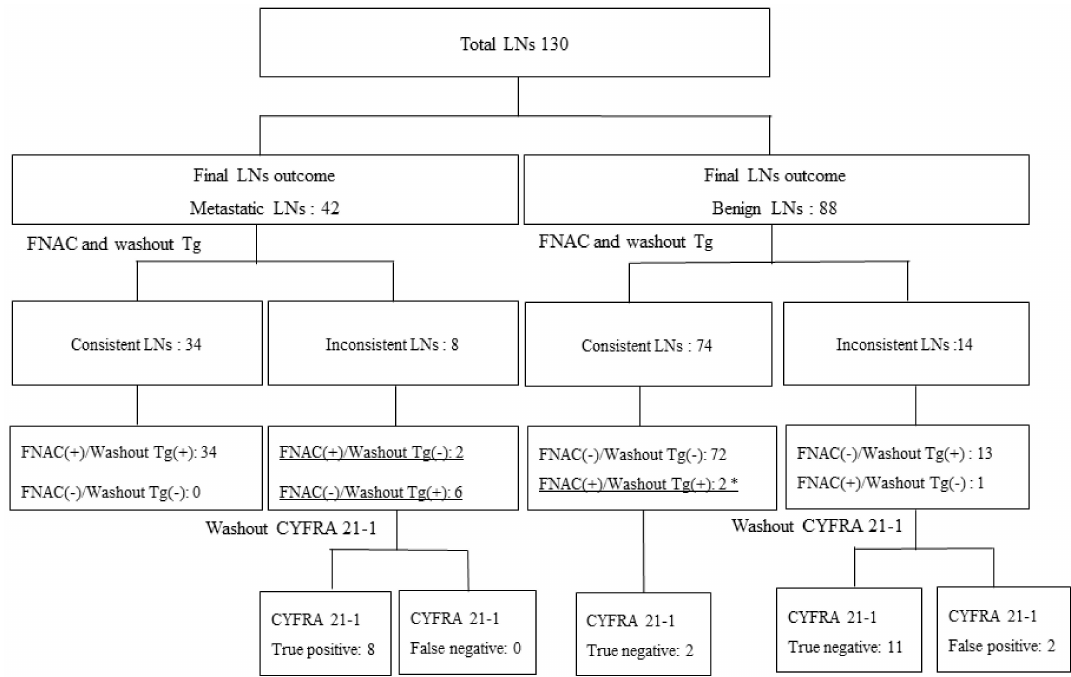
Figure 3. Discordant cases between FNAC and washout Tg 108 of 130 LNs (83.1%) showed concordant results between FNAC and washout Tg. If washout CYFRA 21-1 was applied to these discordant samples, 90.9% of LNs (20 / 22) (eight true positive and 12 true negative) were correctly